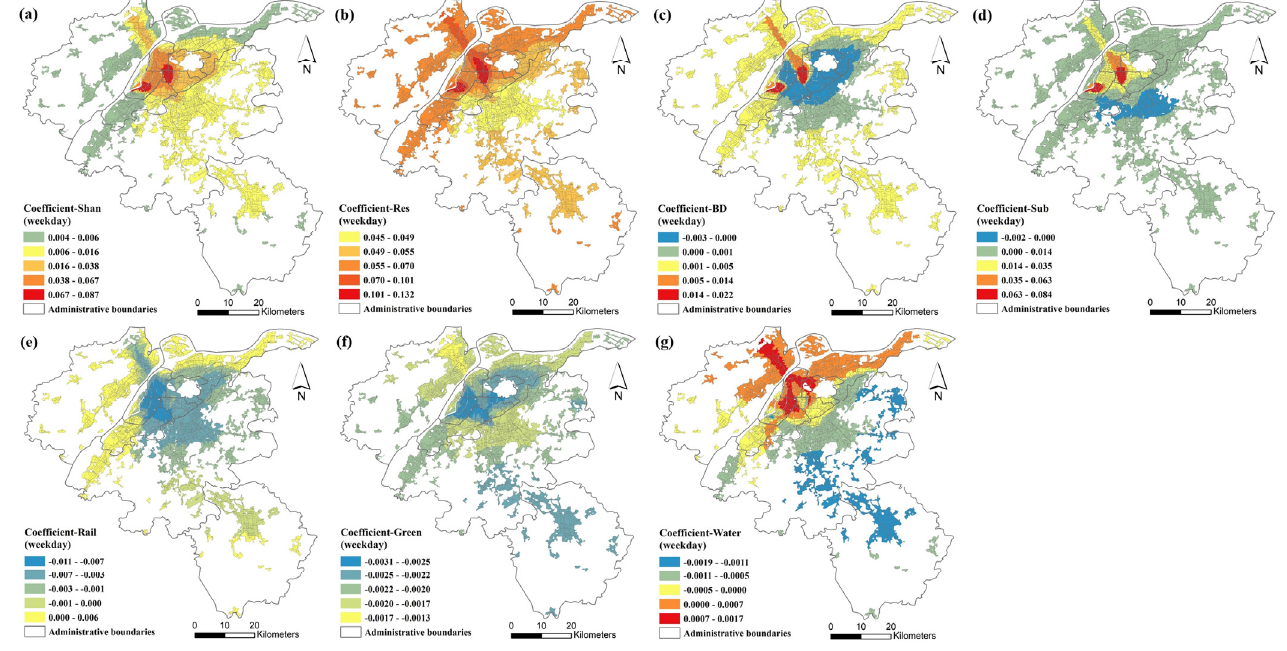
Figure 15. Regression coefficients of driving indicators: ( a ) Shan; ( b ) Res; ( c ) BD; ( d ) Sub; ( e ) Rail; ( f ) Green; and ( g ) Water.